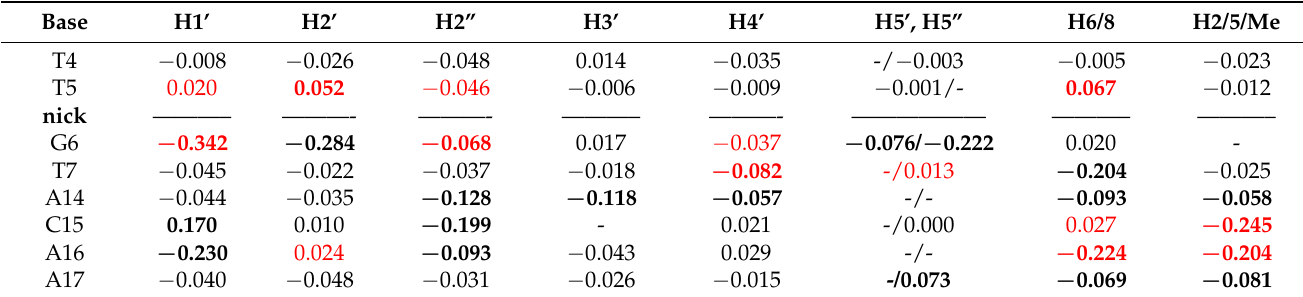
Table 3. The 1 H NMR chemical shifts δ (ppm) of changes between free DNA decamer and 2 after 4 days in D 2 O (1:2 ratio). * (Table S2). Base